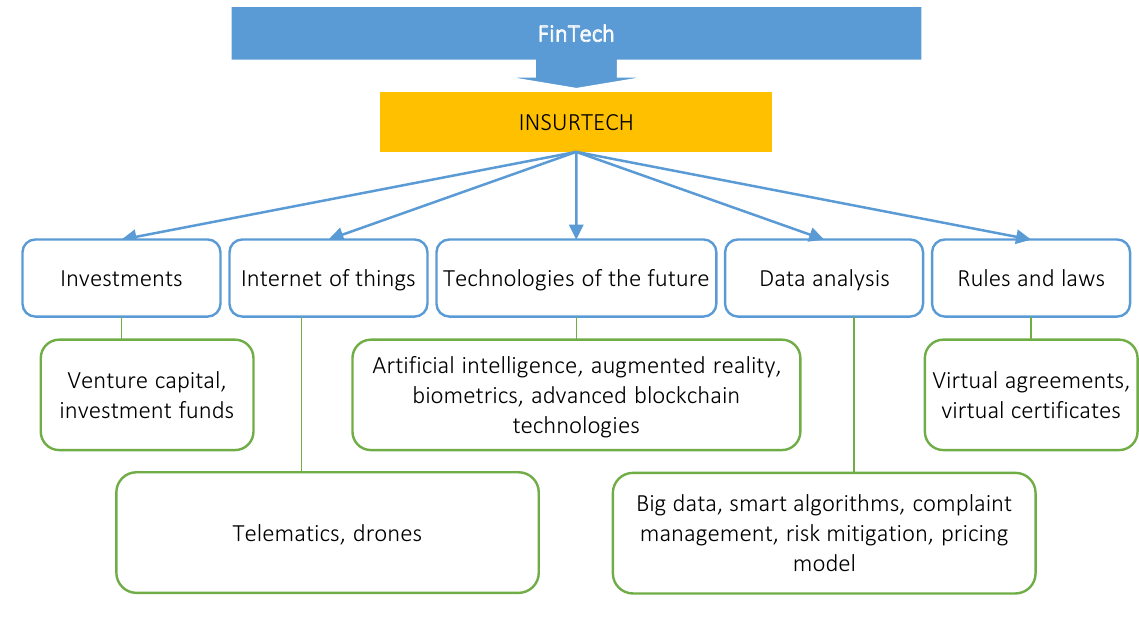
Figure 10. InsurTech